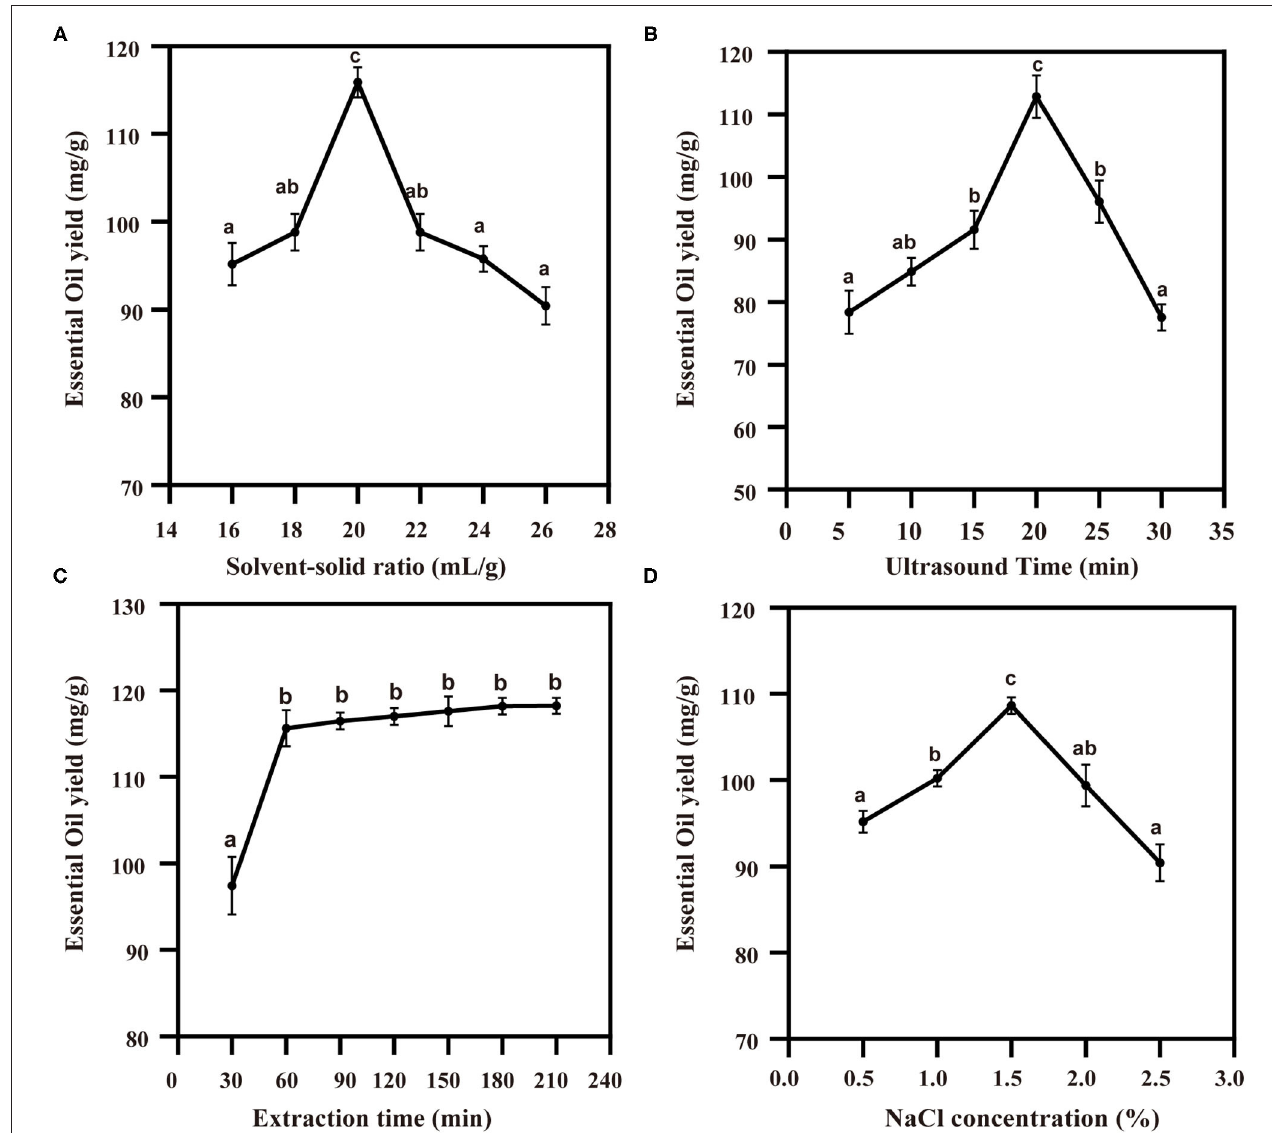
FIGURE 4 | The effect of the ultrasound-assisted extraction on the TCEO yield. (A) The concentration of solvent-solid ratio on the TCEO yield; (B) ultrasound time on the TCEO yield; (C) the extraction time on the TCEO yield; (D) the sodium chloride on the TCEO yield. Values with the same letter are not significantly different p < 0.05 according to ANOVA.